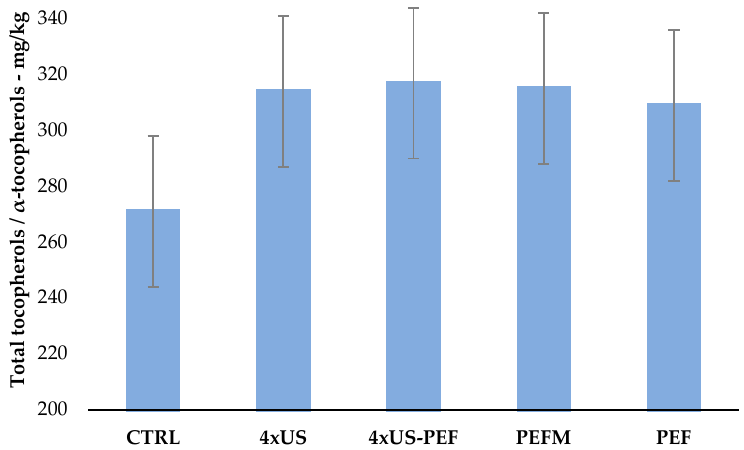
Figure 5. Total tocopherol and tocotrienol content in oil samples obtained from half-ripe Coratina olives according to processing technology (mg/kg) (mean ± U, which represents the expanded measurement uncertainty with a coverage factor k = 2 and a confidence level of 95%).